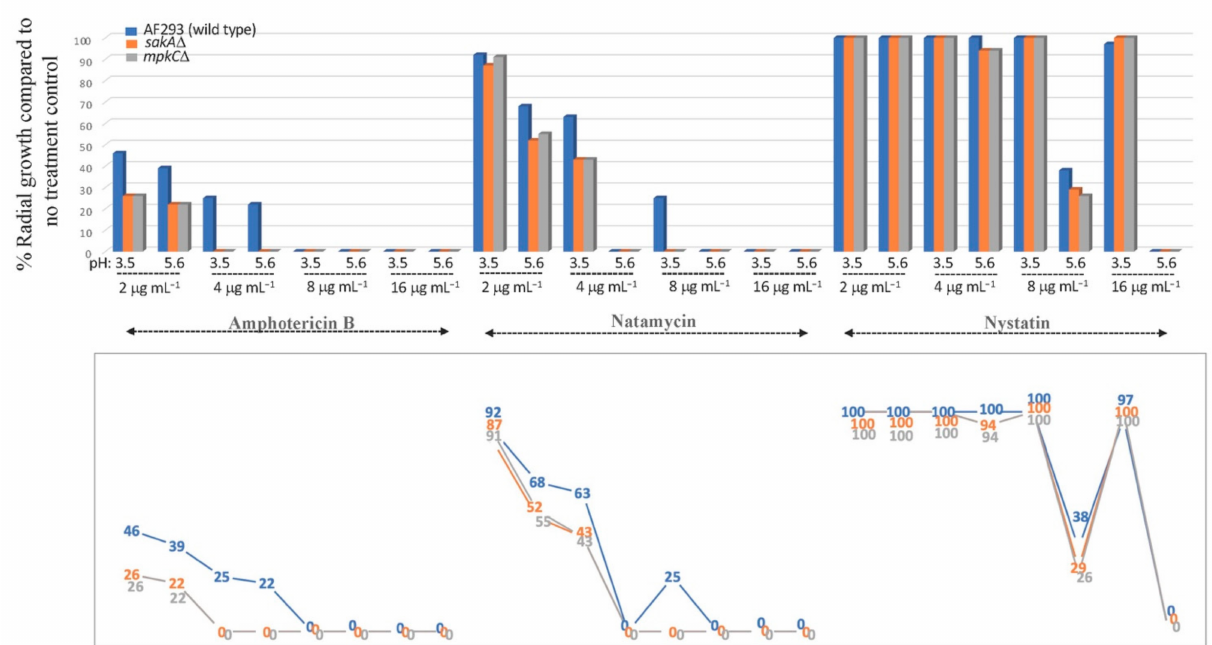
Figure 3. Susceptibility of A. fumigatus AF293 (wild type) and MAPK mutants ( sakA ∆ , mpkC ∆ ) to polyene drugs (ampho- tericin B (AMB), natamycin (NAT), nystatin (NYS); 2, 4, 8, 16 µ g mL − 1 ) tested in PDA (triplicate) at pH 3.5 or 5.6 (SD < 2%). Lower panel: Line graph showing numerical values of % radial growth at each test condition. (Note: While NAT showed higher antifungal activity than AMB at 4 µ g mL − 1 (pH 5.6), where NAT completely inhibited the growth of AF293, the 22% growth with AMB labeled in the graph indicated the appearance of scattered colonies only (not a full radial growth) of